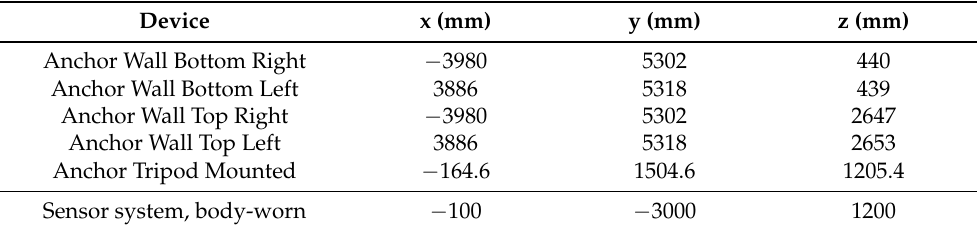
Table 2. The positions of the anchor nodes shown in Figure 9a with respect to the measurement space center.